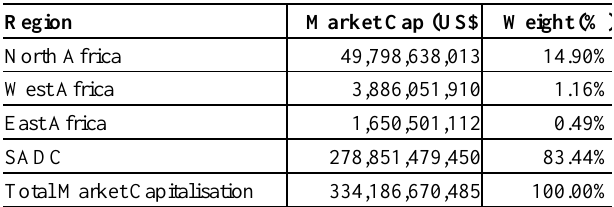
Table 1: Market capitalisation for the four African regions